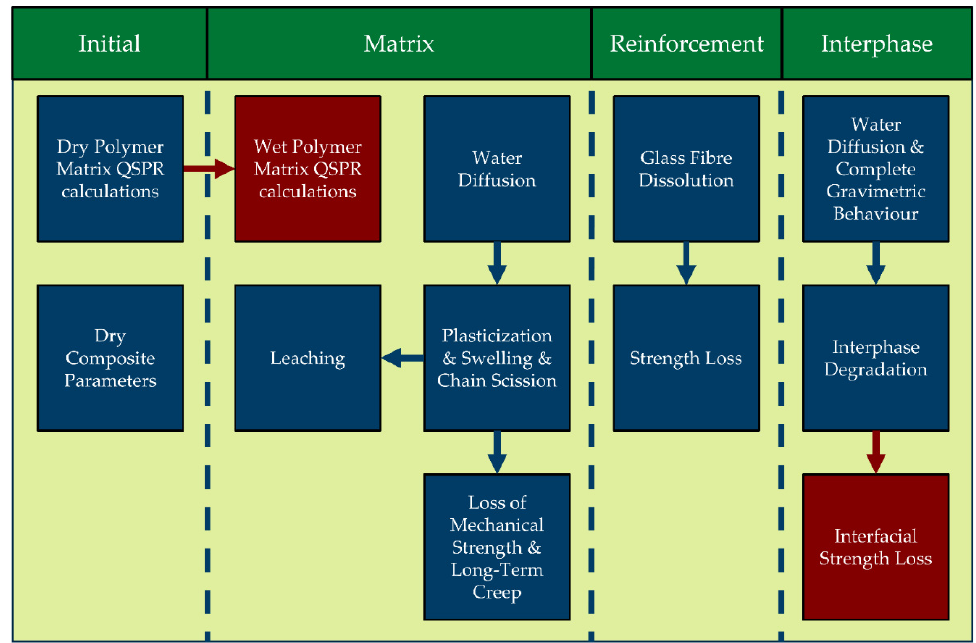
Figure 1. Modeling toolbox modules for predicting environmental ageing of composites, as shown in the original publi- cation [27]. Blue modules are considered complete (albeit some modifications and improvements are expected), whereas red-colored ones require development. QSPR stands for Quantitative Structure–Property Relationships.